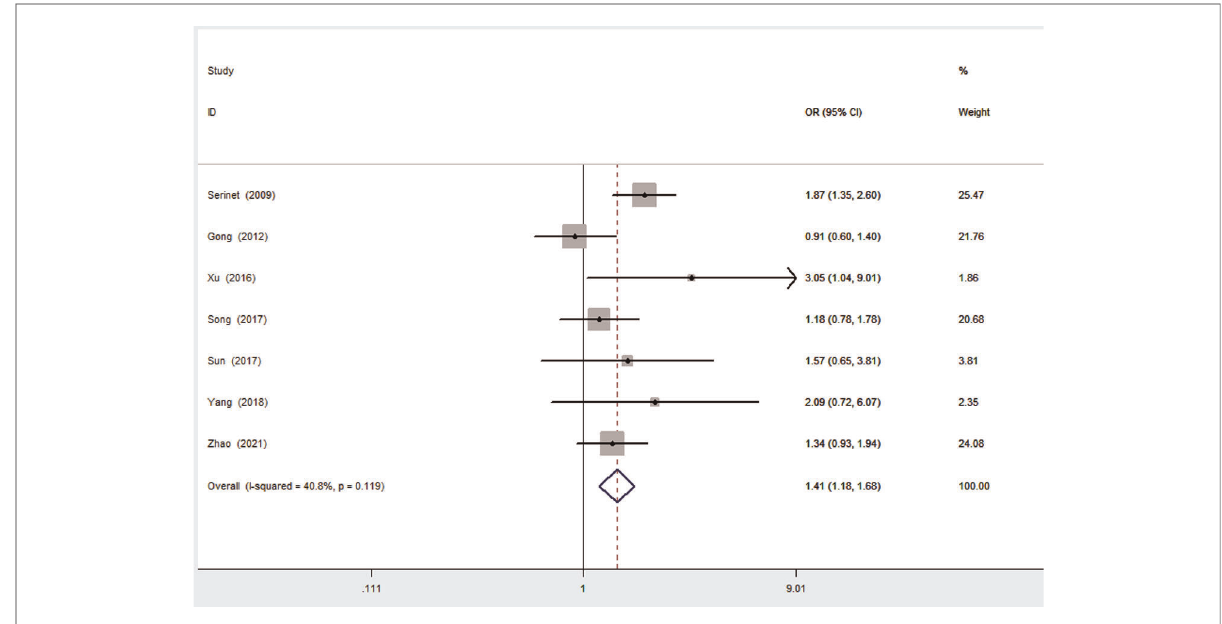
FIGURE 6 Forest plot for NLSR of ≤ 60 days vs. 61 – 90 days group. NLSR, native liver survival rate.